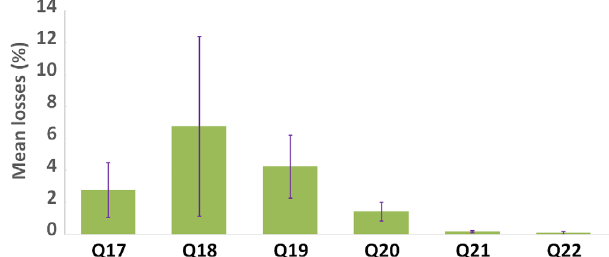
FIG. 6. Transverse misalignment effect on beam losses for each quadrupole of H4-VLE. It is seen that a possible Q18 misalign- ment has an important effect on the beam losses.